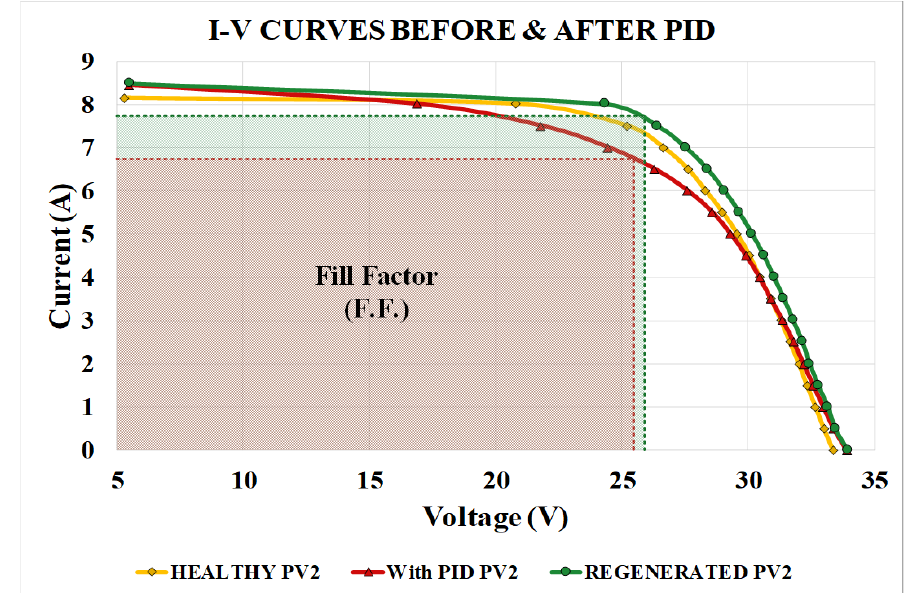
Figure 20. Comparison between the measured I-V characteristic curves of the PV 2 panel, before PID, with PID and after regeneration. Table 4. Experimental Maximum Power Point (MPP) for the reference PV (PV 1 ) and for the PV un- der test (PV 2 ) before and after PID occurrence and with PID regeneration.